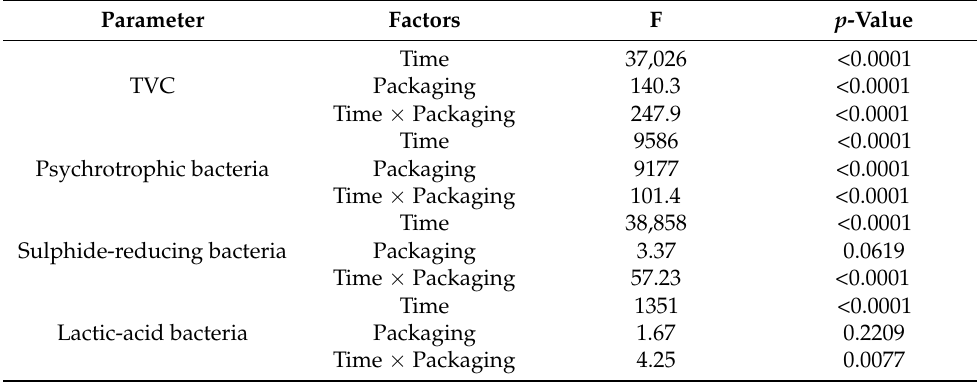
Table 3. Results of ANOVA per microbiological quality parameter considering factors time (0, 1, 5, 10, and 15 days) and packaging (AIR, VP, and